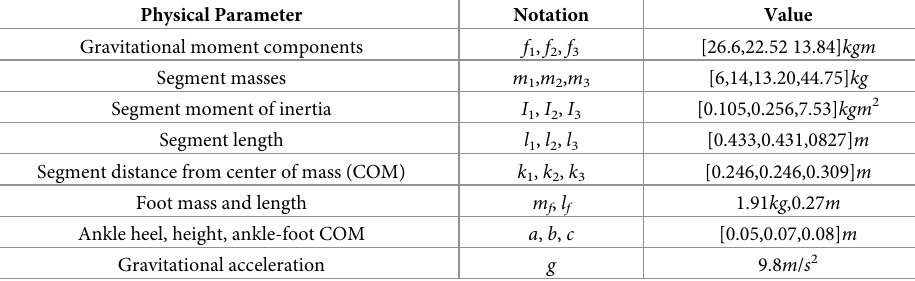
Table 1. Biomechanical parametric values used in